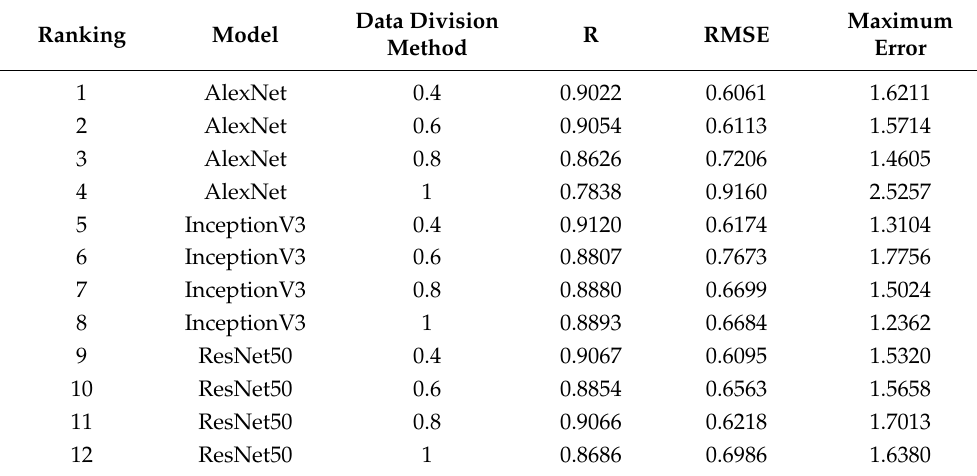
Table 1. Comparison results of the models based on the loss1